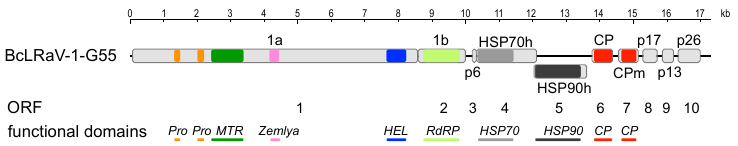
Figure 1. Schematic representation of the genomic organization of the Gabreta 55 (G55) isolate of blackcurrant leafroll associated virus 1 (BcLRaV-1-G55). The genome is drawn as a black line, and the predicted open reading frames (ORFs) are represented by shaded rectangles. Annotations, ORF numbers, and identified functional domains are given below. Abbreviations: Pro—papain-like leader proteinase, Zemlya—see text for description, MTR—methyltransferase, HEL—helicase, RdRP—RNA-dependent RNA polymerase, HSP70—heat-shock protein 70, HSP90—heat-shock protein 90, CP— capsid protein, and CPm—minor capsid protein.